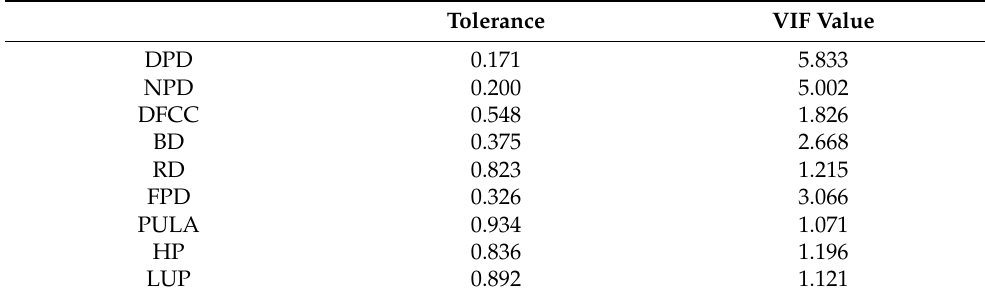
Table 2. The collinearity test of impact factors of 3DSFD in Kunming’s Main Urban District.